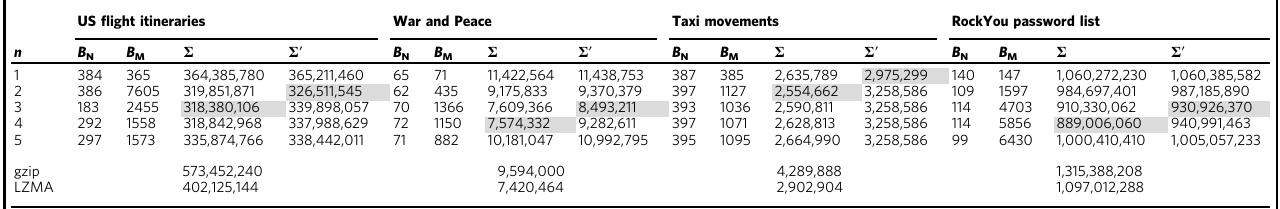
Table 1 Summary of inference results for empirical sequences US fl ight